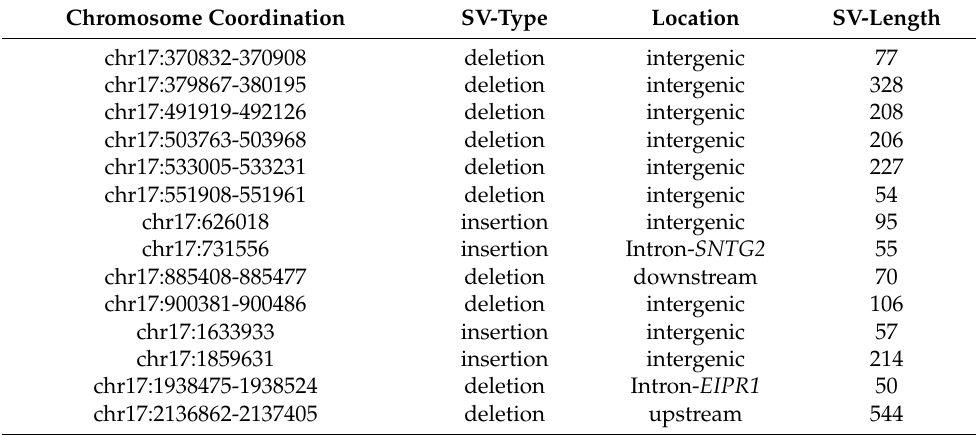
Table 2. Private SV variants for